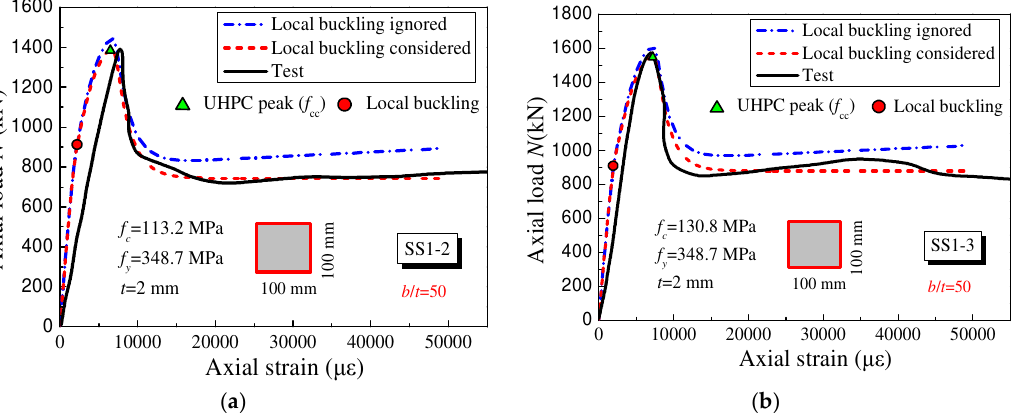
Figure 6. The comparisons of predicted N- ε curves with test results (Chen et al. [33]). ( a ) SS1-2 ( b ) SS1-3.